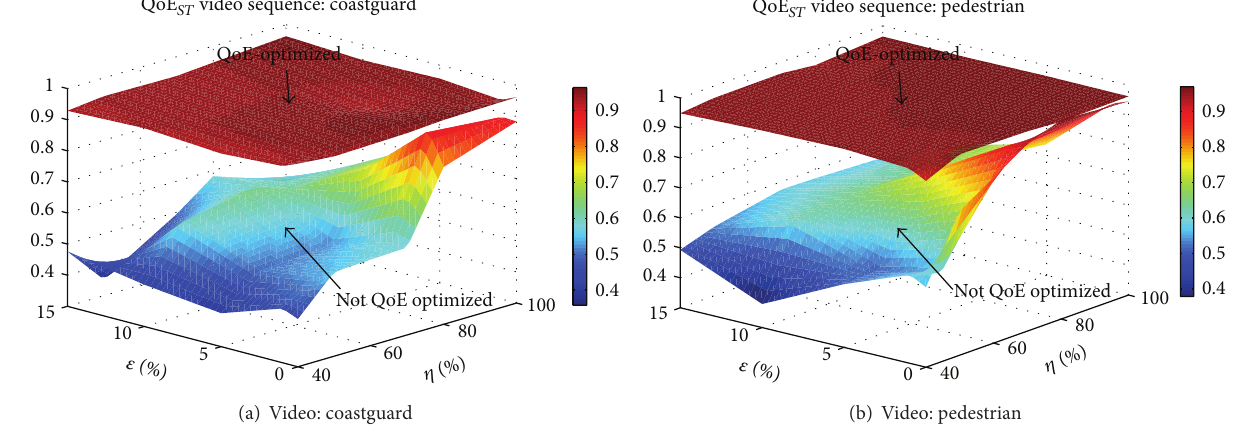
Figure 6: QoE 𝑆𝑇 metrics for joint QoE in space and time